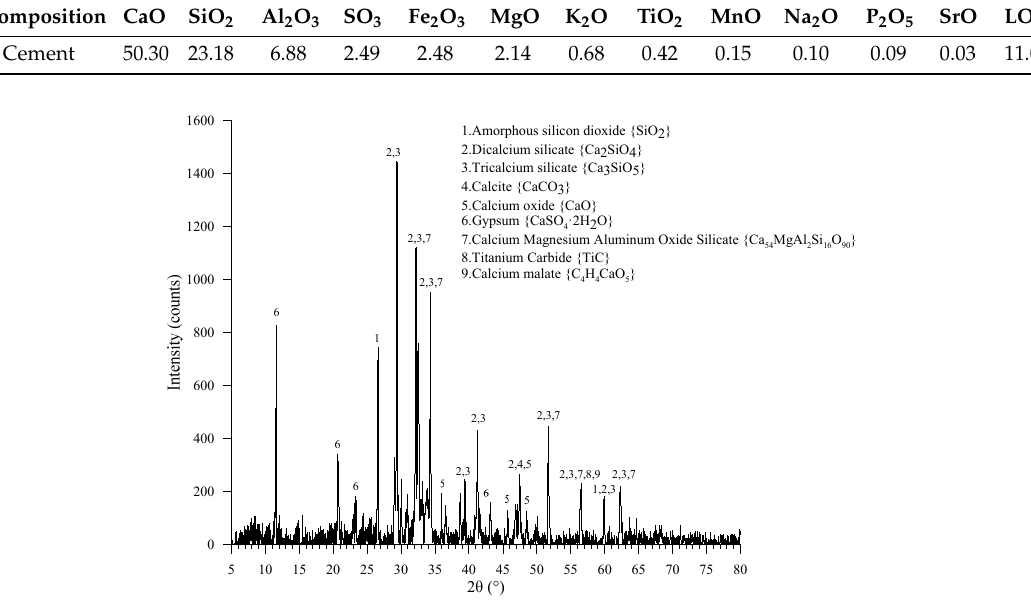
Table 1. Chemical compositions of cement used.